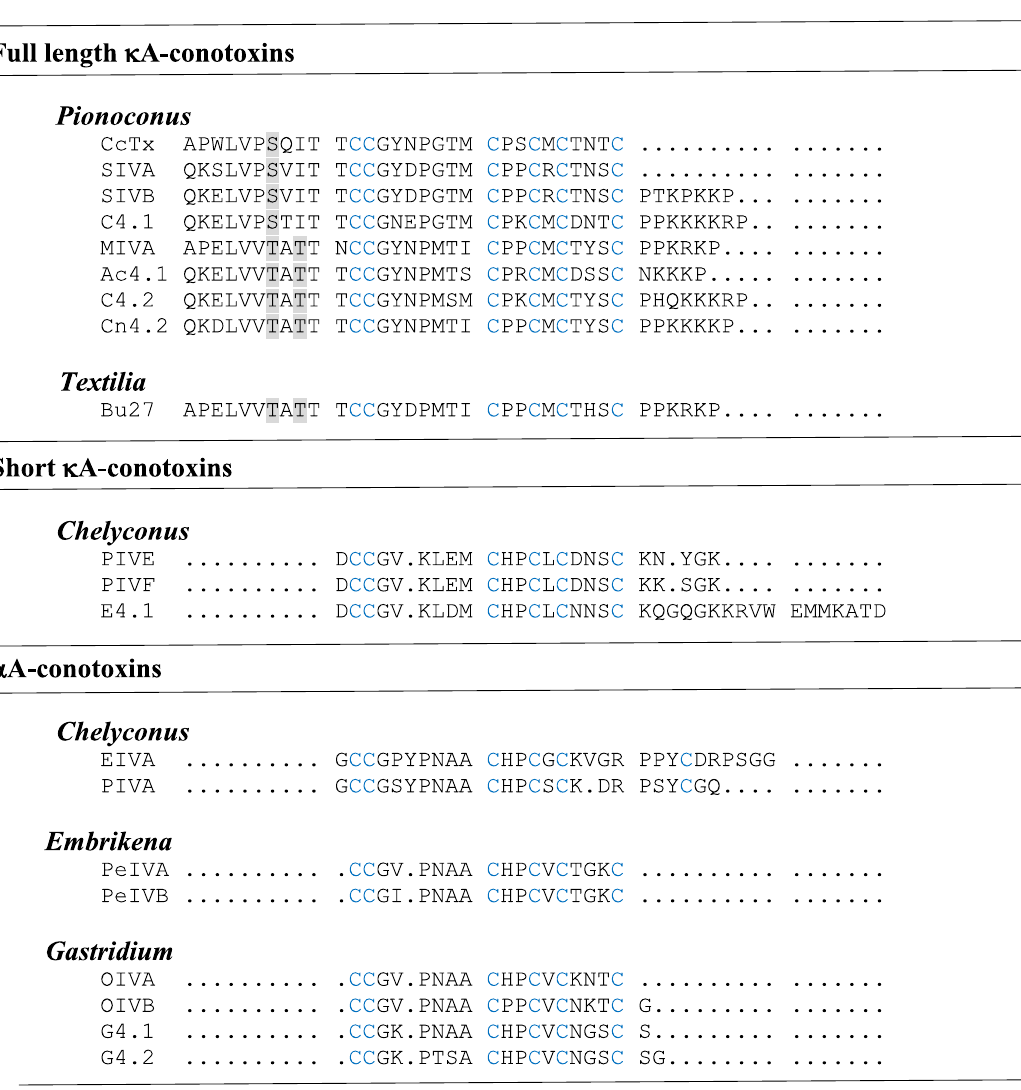
Table 2. Complexity and the distribution of the A superfamily Cysteine framework IV peptides across fish hunting clades of cone